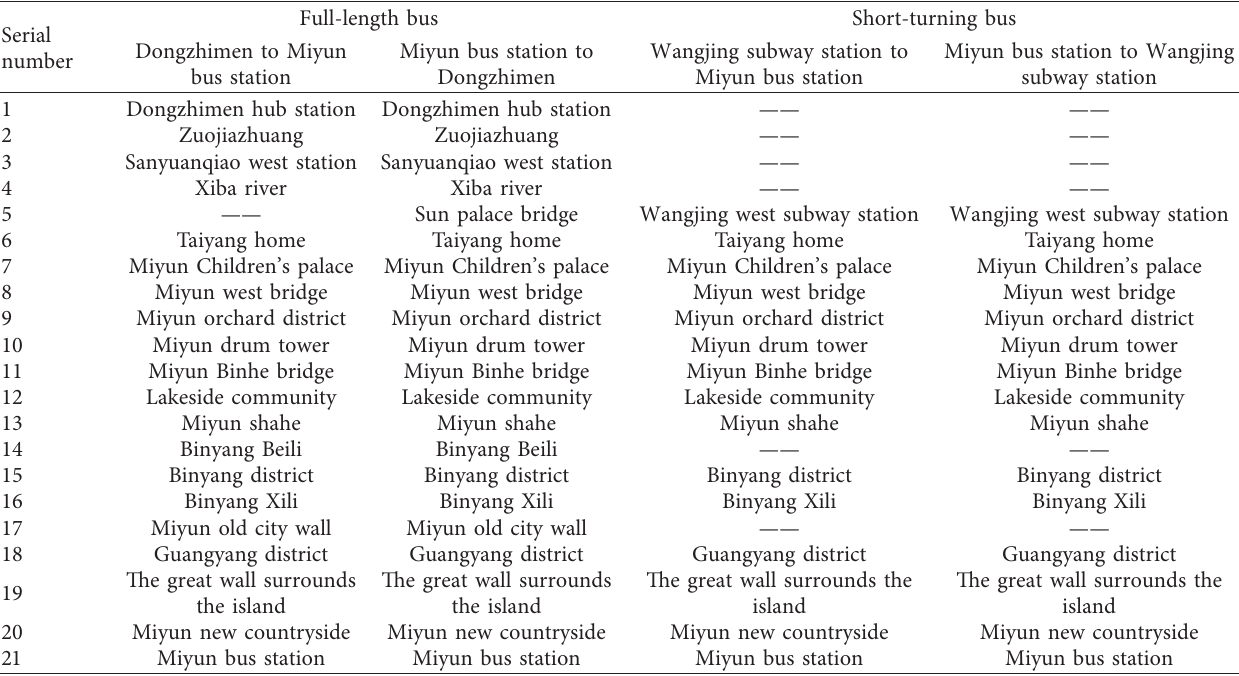
Table 1: Bus line stop information.